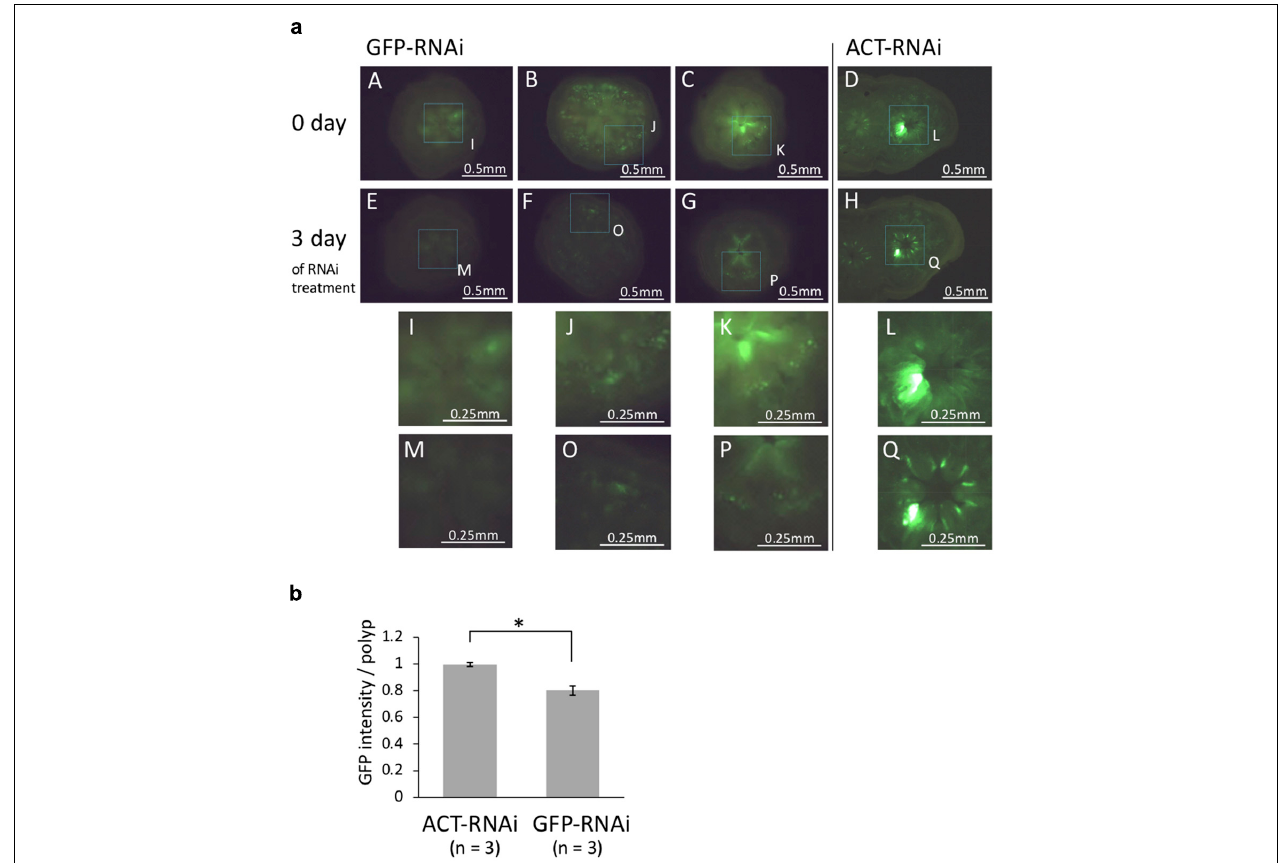
FIGURE 3 | (a) Fluorescence microscopy images of juvenile polyps (day 6 after metamorphosis) treated with GFP-dsRNA and ACT-dsRNA. Corals treated with ACT-dsRNA were prepared as a control group to confirm the response was specific to GFP-dsRNA. GFP-dsRNA-treated corals showed a tendency toward decreased green auto-fluorescence. (A–E, B–F, C–G, and D–H) Show the same colonies before-after treatment with each dsRNA. (I–Q) show higher magnification of dashed box region in A–H. The same part in the photos before-after dsRNA treatment is surrounded by dotted lines. The same area of the two figures (before-after treatment) is surrounded by dotted lines and enlarged. (b) The rate of change in GFP content (after-RNAi/pre-RNAi). The GFP contents were estimated from juvenile polyps ( n = 3) treated with GFP-dsRNA or ACT-dsRNA using the RawIntDen function of imageJ. The green fluorescence intensity was decreased in corals treated with GFP-dsRNA. Bars represent the mean GFP fluorescence intensity of corals treated with ds-GFP or ds-ACT. Error bars are standard error. Asterisk indicate significant differences ( p < 0.05).